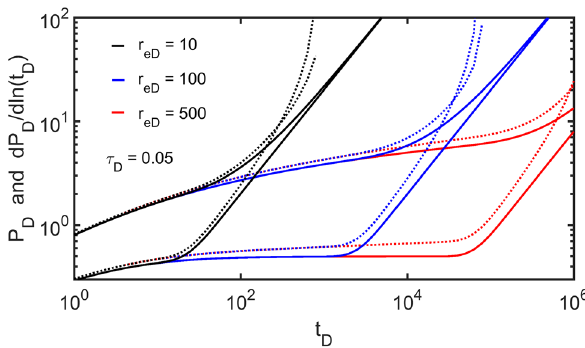
Fig. 6 Pressure and pressure derivative, non-linear (broken curves) and linear (solid curve)